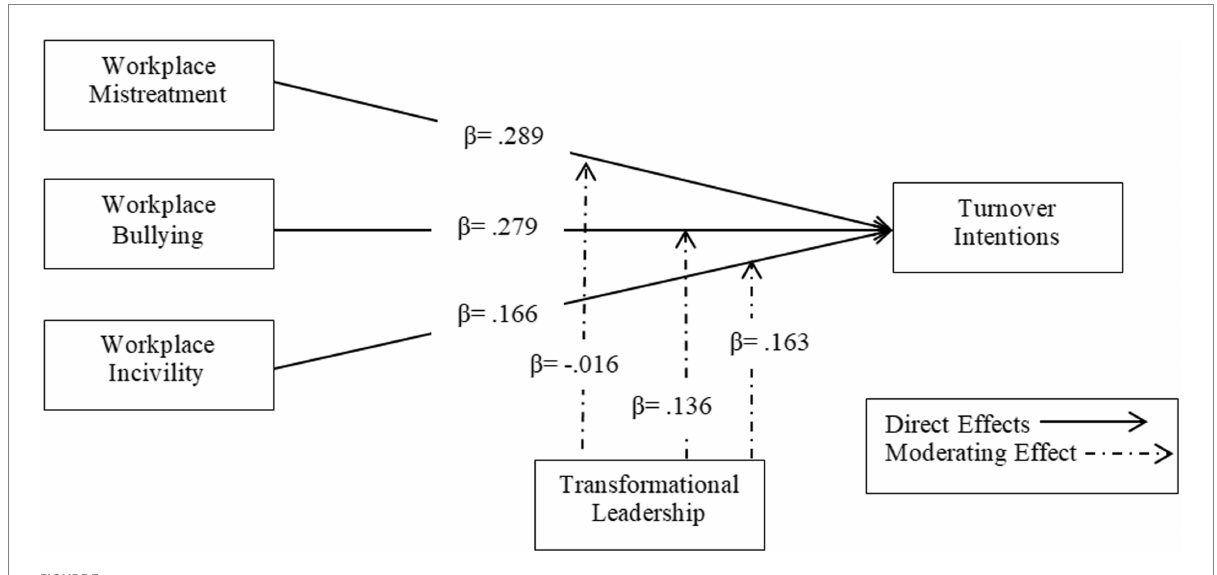
FIGURE 4 Moderating effect of TL between WM and